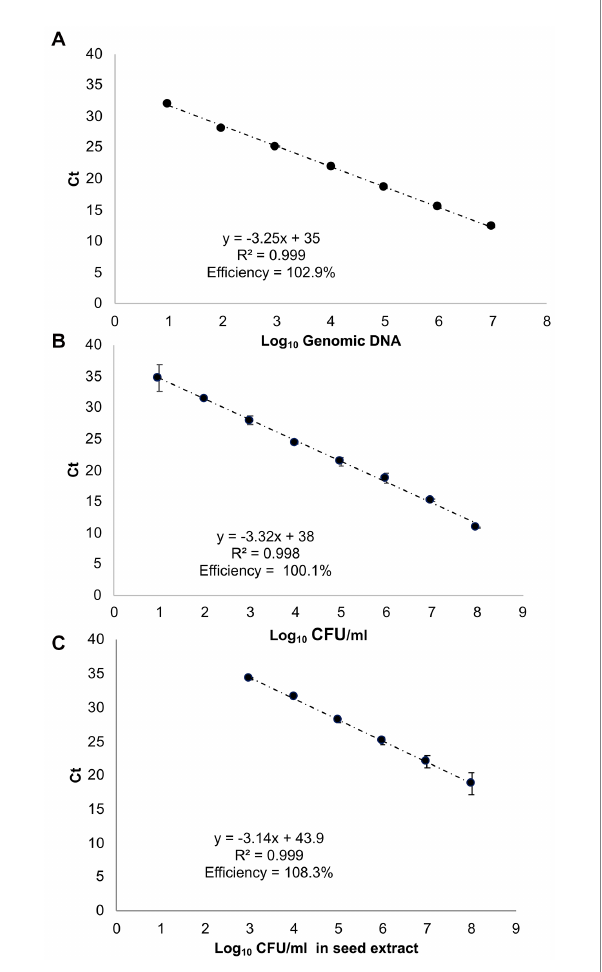
FIGURE 2 Standard curves of real-time PCR with cycle threshold (Ct) values plotted against (A) 10-fold serial dilutions of genomic DNA of Pss strain IPV-BO 2766 (indicated as Log 10 of fg of genomic DNA); (B) 10- fold serial dilutions of the bacterial cell (Log 10 of CFU/ml); (C) the 10-fold serial dilutions of the bacterial cell employed to spike the seed extract (Log 10 CFU/ml). The Ct value is the mean of three replicates from two independent